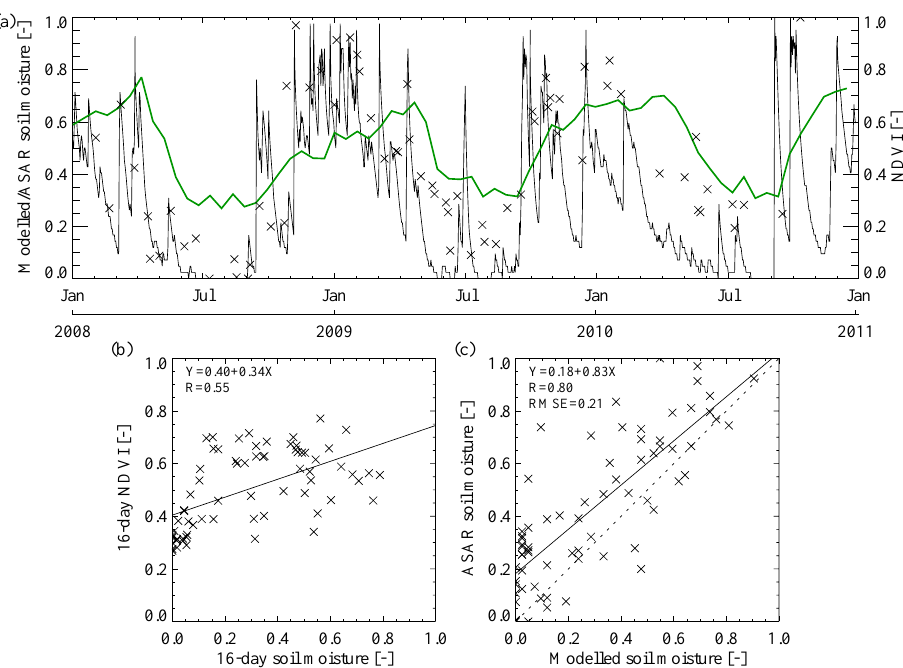
Fig. 5. Temporal behaviour of modelled soil moisture (black line), NDVI (thick green line) and ASAR soil moisture (crosses) for a pixel over arable land (a) ; scatterplot of modelled soil moisture, averaged over 16 days, and 16-day NDVI for the same pixel (b) ; scatterplot of modelled soil moisture and ASAR soil moisture for the same pixel (c) .